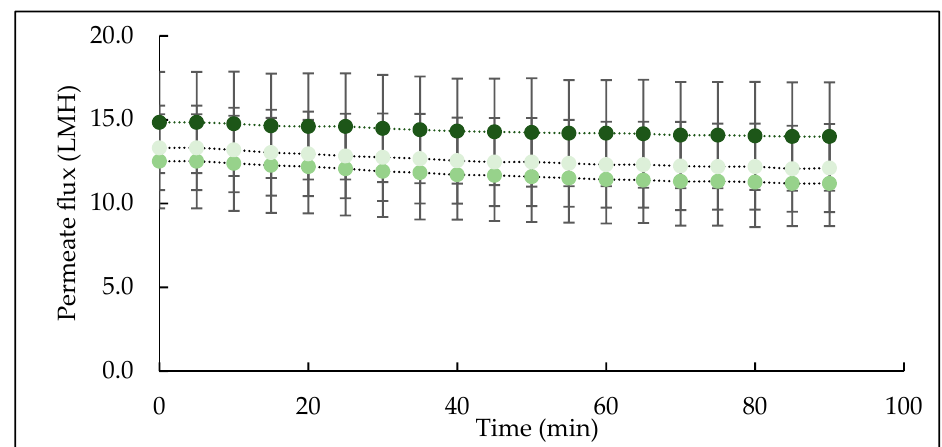
Figure 4. Permeate flux as a function of processing time during microfiltration of micellar casein concentrate feed using a 0.1 µ m membrane at 5 ± 0.5 ◦ C. Line colour represents: CTR ( • ), TA ( • ), TB ( • ); Values are the means ± standard deviations of data from triplicate runs at each treatment. LMH: L/m 2 /h; CTR: no enzyme treatment; TA: 5 ◦ C/24 h; TB: 40 ◦ C/90 min.